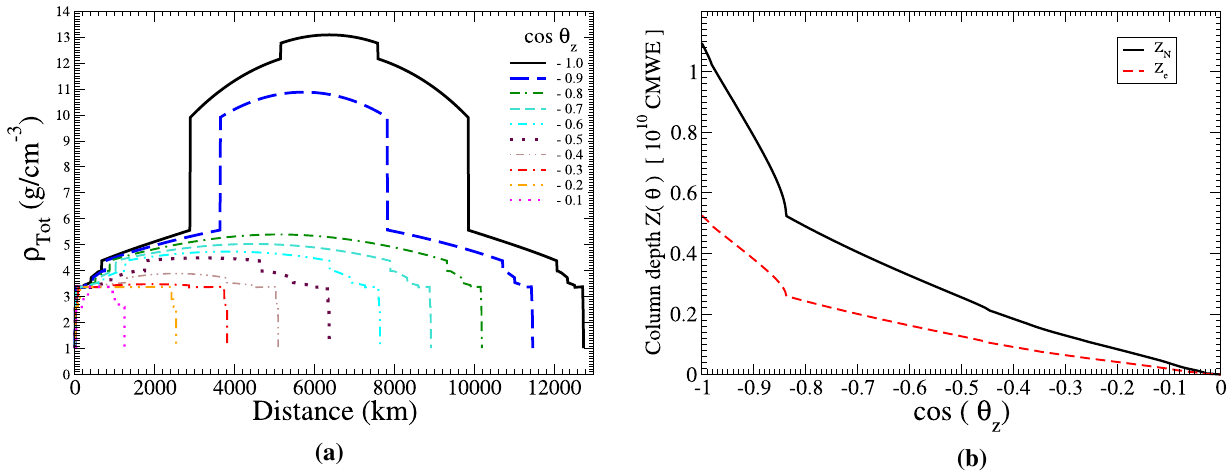
Fig. 2 a Relation between the total distance traveled and the total density felt by the neutrinos while crossing the Earth, for the differ- ent incoming neutrino directions which are indicated by the values of cos θ z quoted in the plot. b The thickness of the Earth, which is defined